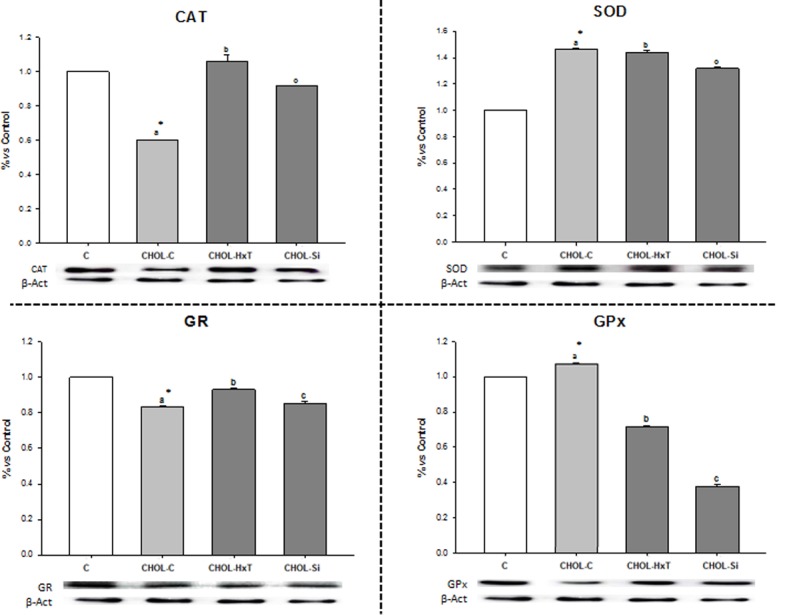
Effect of silicon or hydroxytyrosol-restructured pork on liver enzymatic antioxidants in aged rats fed high-saturated/high-cholesterol diets.Mean values and standard deviations (n 6). C, control diet; CHOL-C, cholesterol enriched high-saturated/high-cholesterol control diet; CHOL-HxT, hydroxytyrosol RP cholesterol enriched high-saturated/high-cholesterol diet; Si, silicon RP cholesterol enriched high-saturated/high-cholesterol diet. Statistical comparison between C and CHOL-C diets, * indicate significant differences (at least p<0.05). Bars with different letters indicate significant differences (at least p<0.05) between CHOL-C, CHOL-HxT and CHOL-Si groups. CAT, catalase; SOD, superoxide dismutase; GR, glutathione reductase; GPx, glutathione peroxidase. Results were calculated as percentage relative to control.